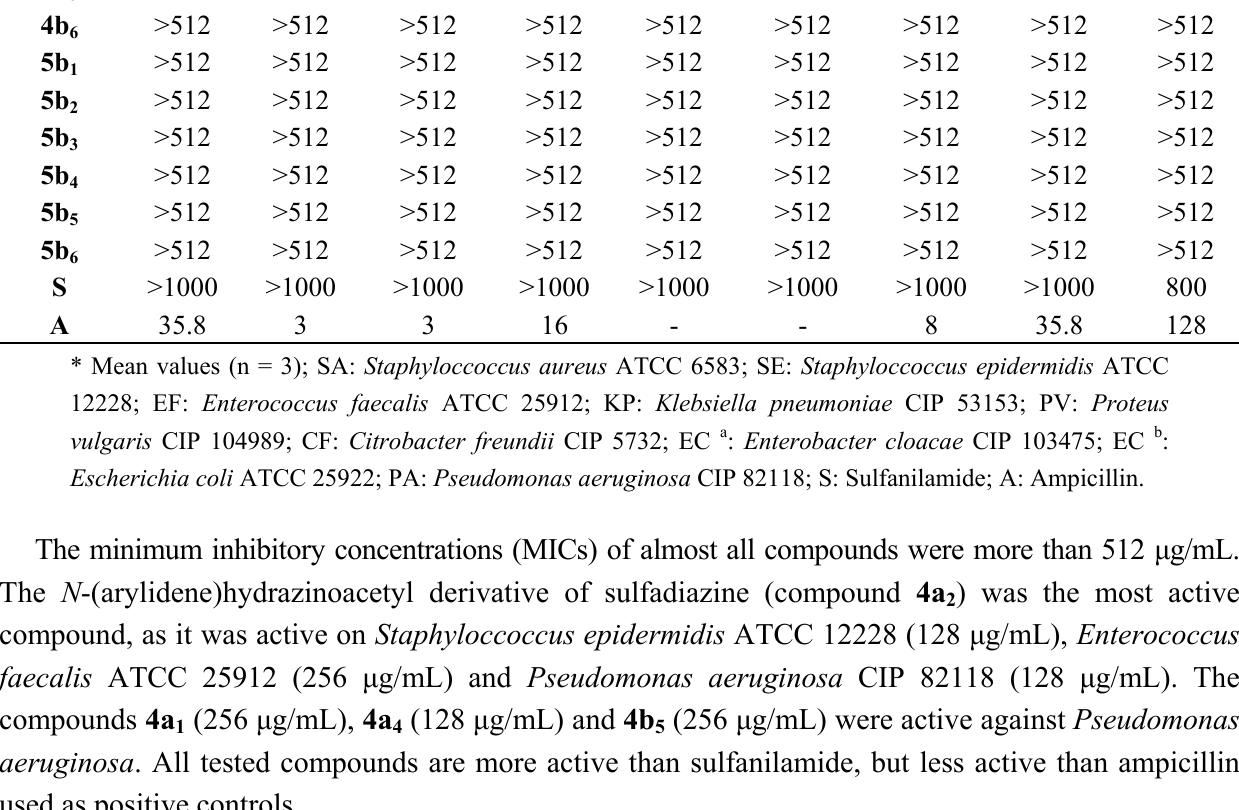
Table 2. MIC values (µg/mL) of the sulfisoxazole derivatives 4b